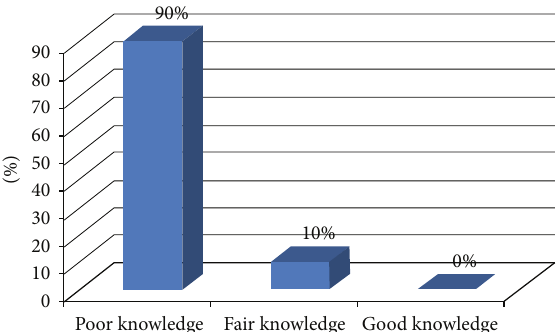
Figure 1: The distribution of nurses of Mekelle Zone Hospitals according to their knowledge on nursing assessment, Mekelle, northern Ethiopia, March 2011 ( 𝑛 = 200 ).